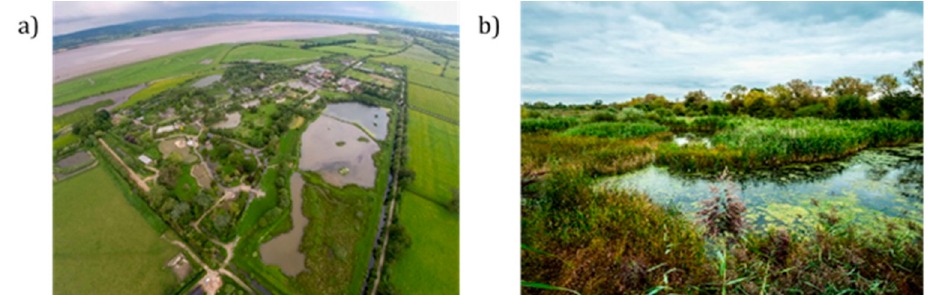
Figure 1. ( a ) The wetland nature-based health intervention took place within a Wildfowl & Wetlands Trust (WWT) wetland site in Gloucestershire, UK. ( b ) The site allows visitors to interact with wetland nature in multiple ways, including canoeing through reed beds. (Photos from WWT)